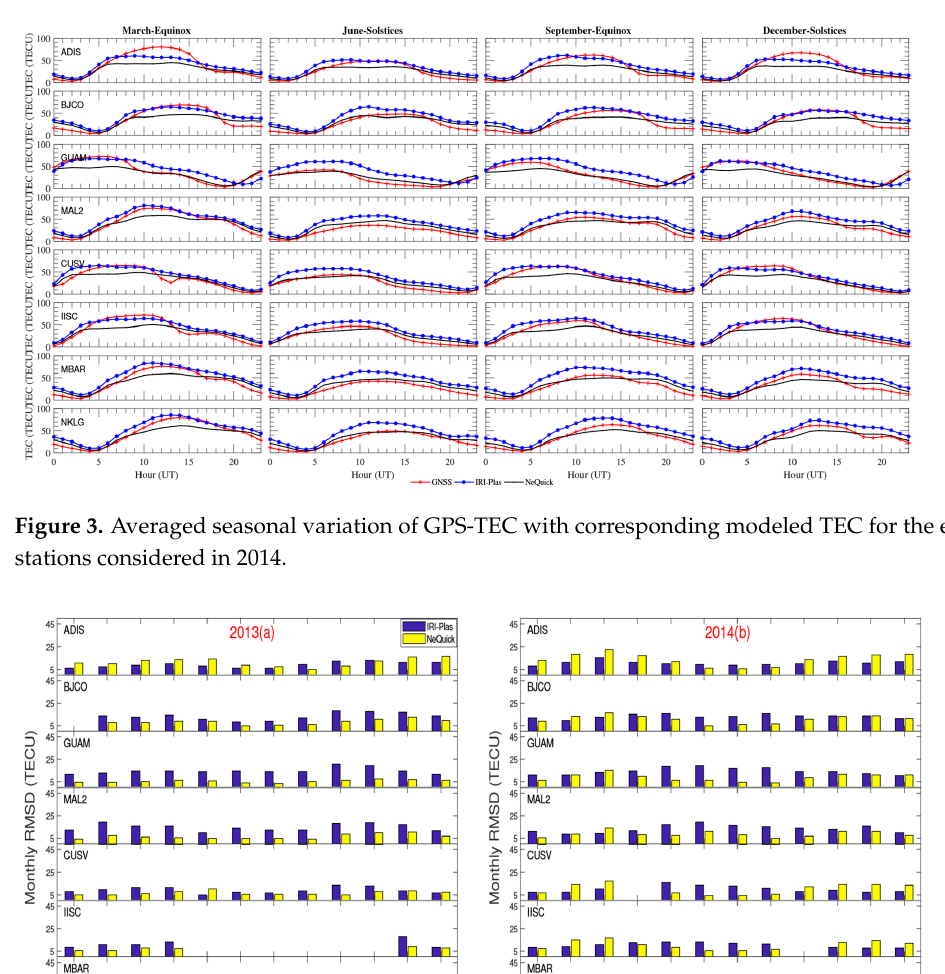
Figure 5. Averaged seasonal Percentage Deviation of IRI-PLAS and NeQuick model for the entire stations considered in the year 2013.